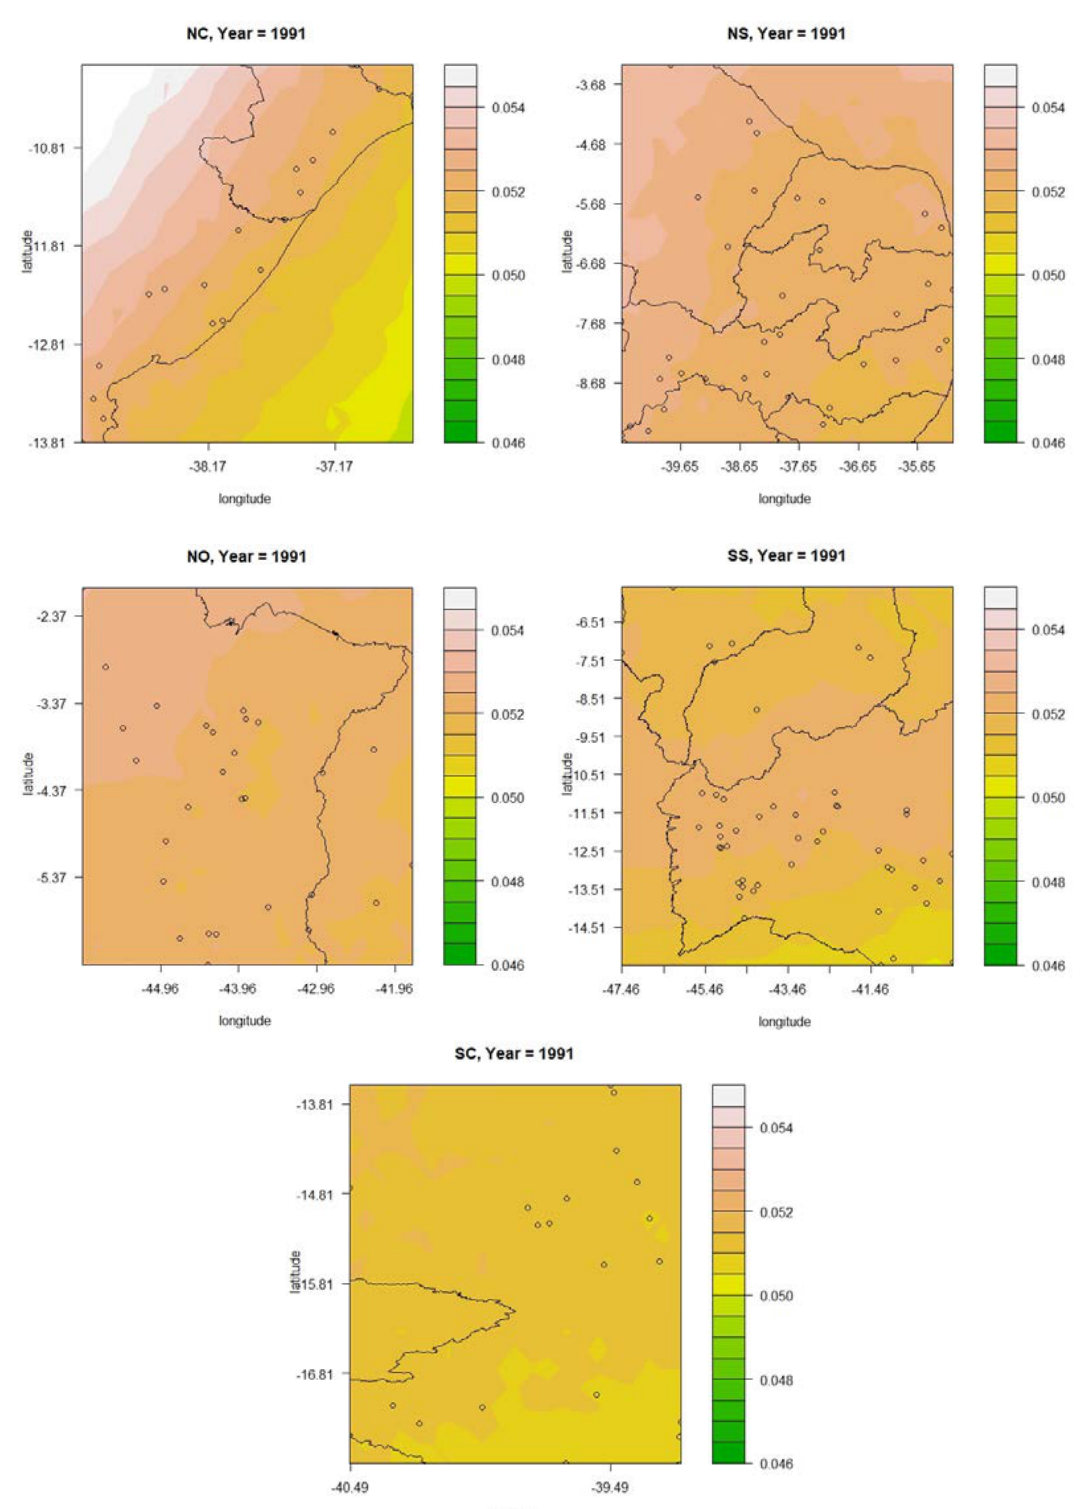
Figure 5. Predictions of rainfall relative frequency that exceeded 95th threshold in the NC, NS, NO, SS and SC regions in 1991. Table 3. Posterior mean, median and 95% credibility interval for the parameters ( is the intercept, is the coefficient associated with longitude and coefficient associated with latitude) of the model adjusted for an estimate of the R* mm index in the 𝛹𝛹′ = ( 𝛹𝛹 0 , 𝛹𝛹 1 , 𝛹𝛹 2 ) 𝛹𝛹 0 𝛹𝛹 1 NC, NS, NO, SS and SC regions.